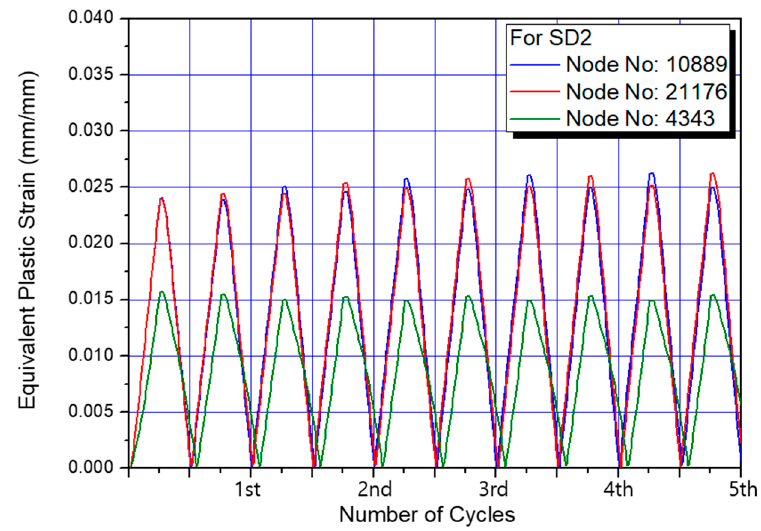
Figure 14. Analysis results of equivalent plastic strain time history during cyclic load for SD2.